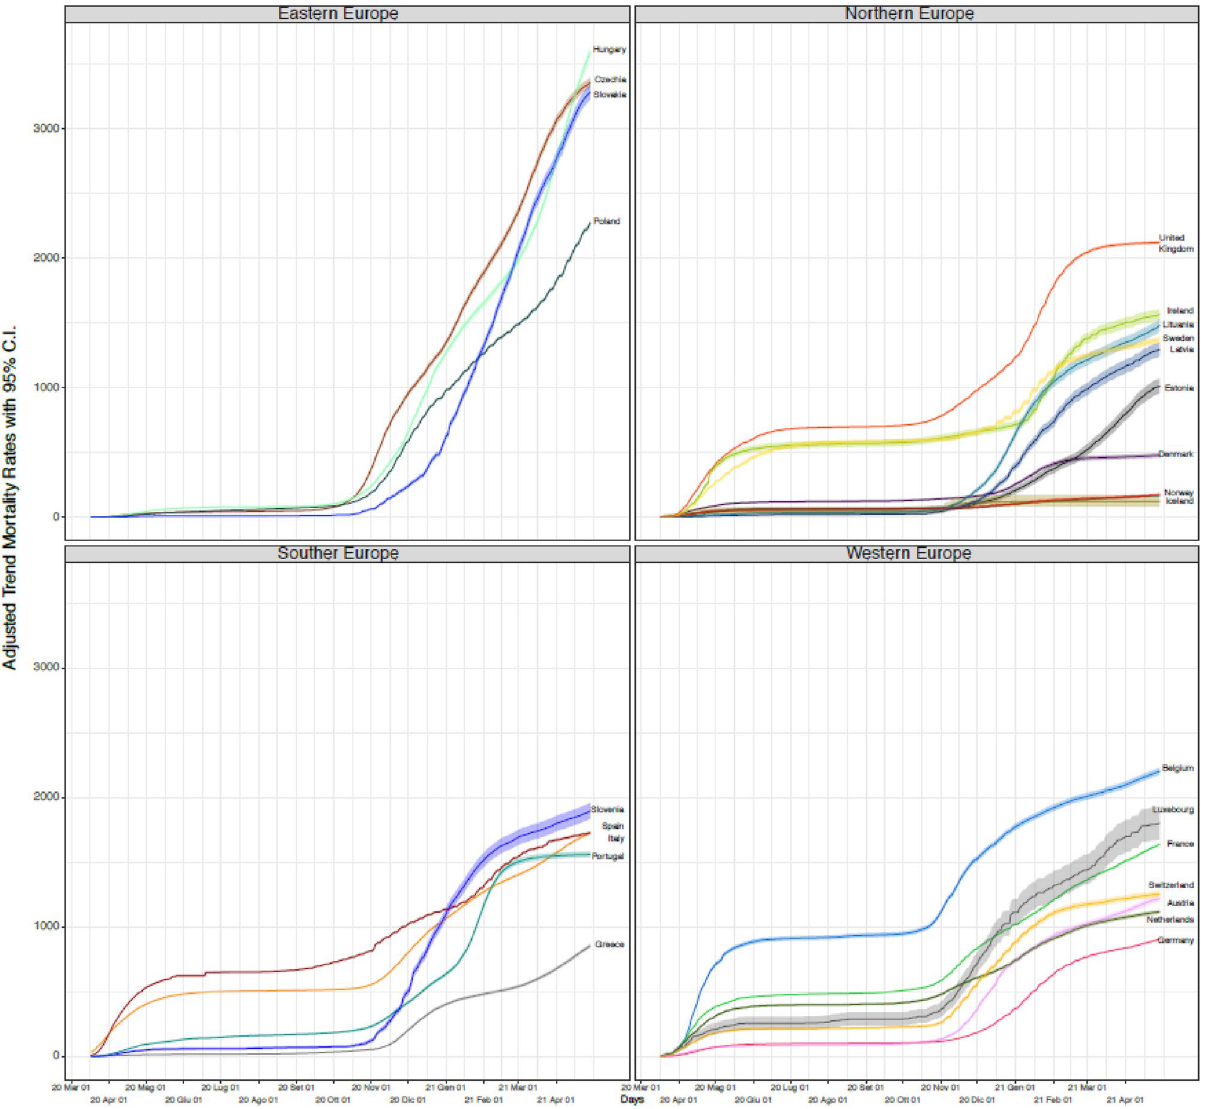
Figure 3. Adjusted Mortality Trend Rates (AMTRs) per 1,000,000 inhabitants due to mortality from COVID- 19 in European countries from 17/03/2020 to